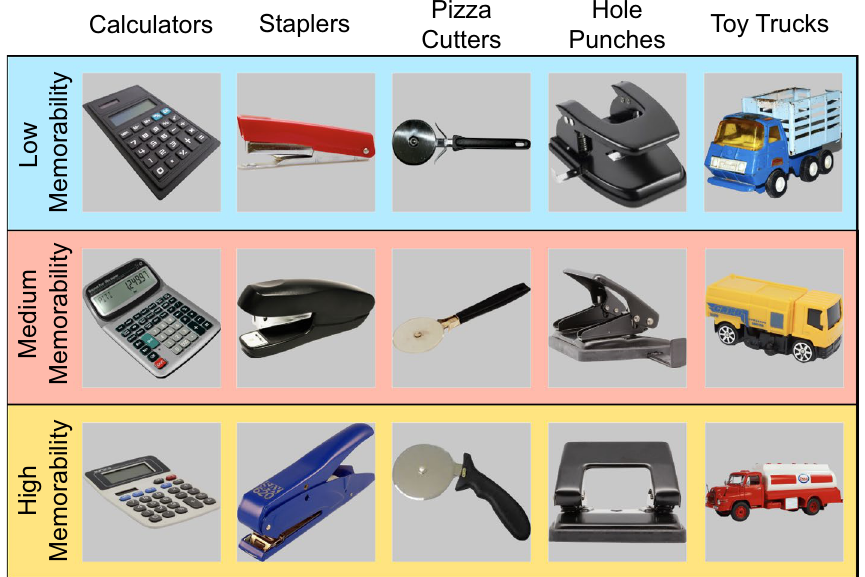
Figure 3. Example of stimulus categories with exemplars included in low-, medium-, and high-memorability conditions. These examples demonstrate that the three memorability conditions are not grouped based on obvious perceptual